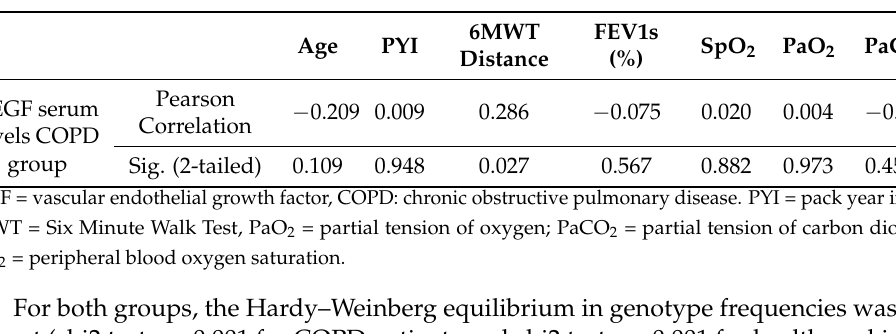
Table 2. Correlation between the VEGF serum level and the characteristics of the COPD